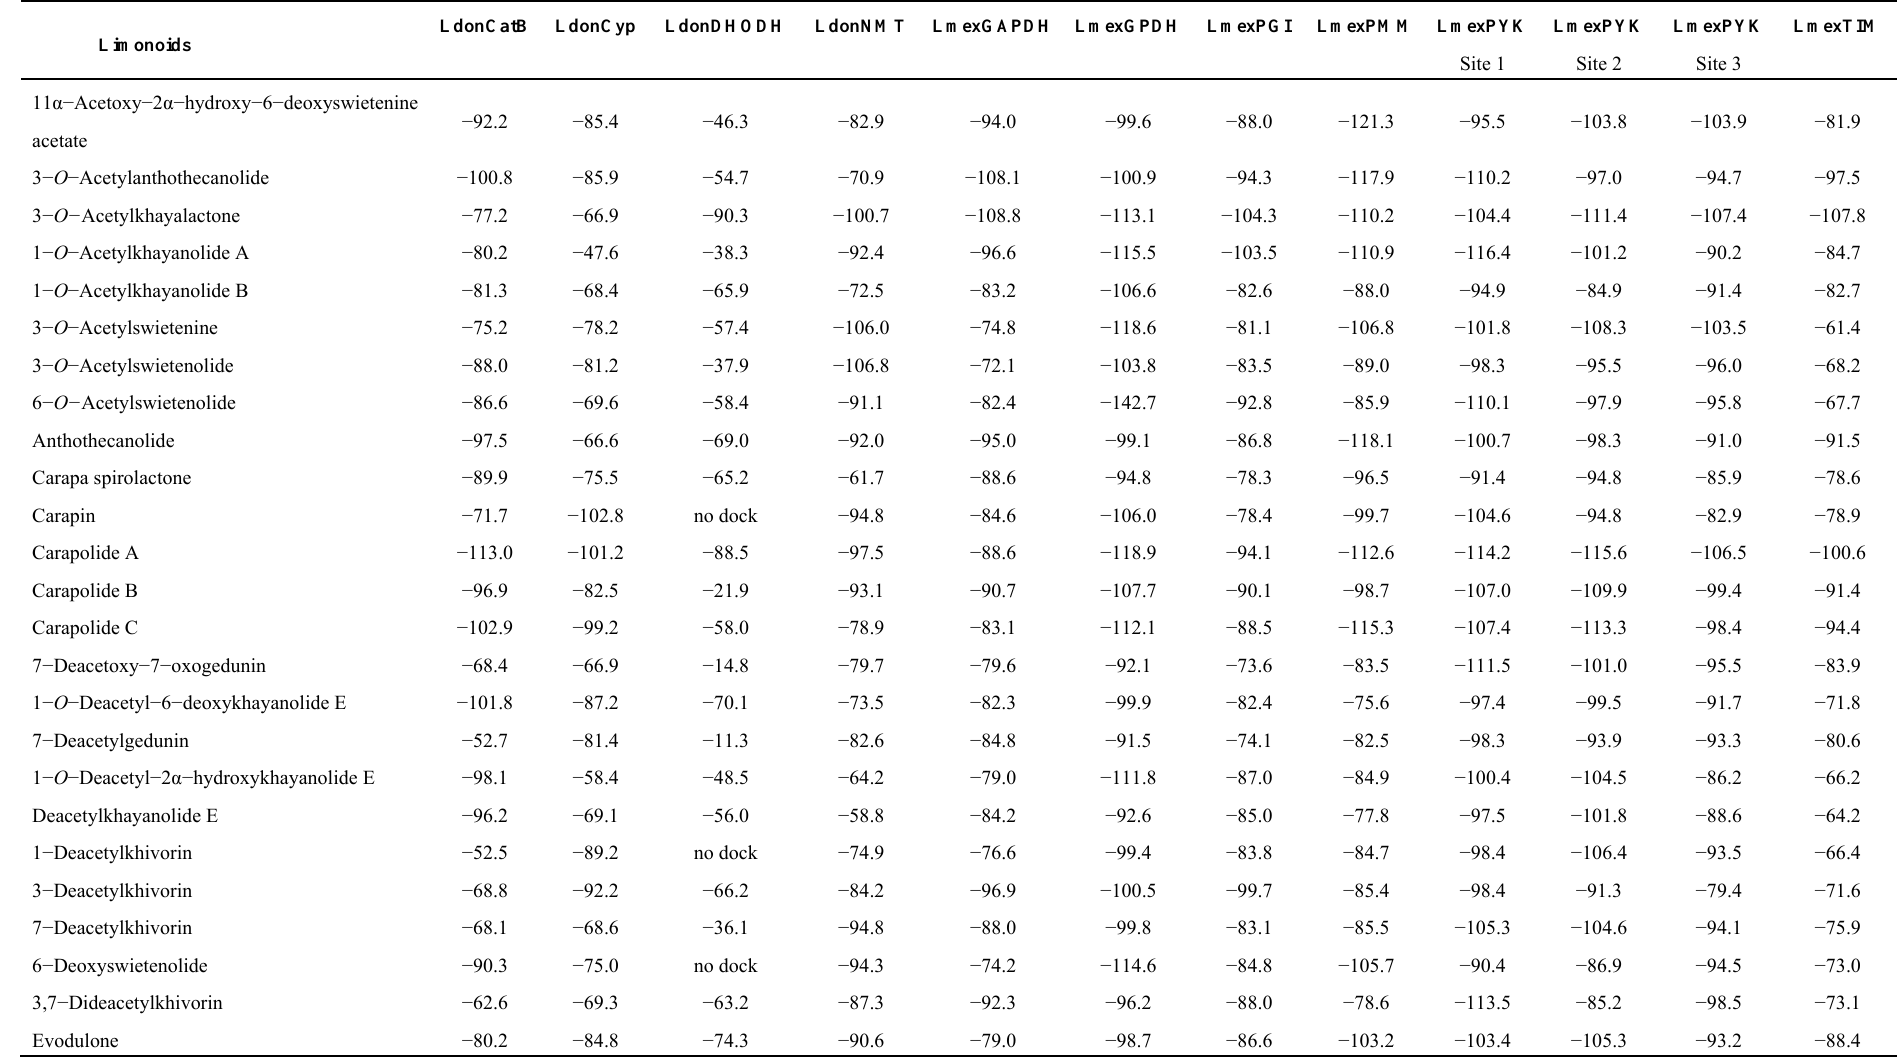
Table 30. MolDock docking energies (kJ/mol) of limonoids with Leishmania donovani and L. mexicana protein